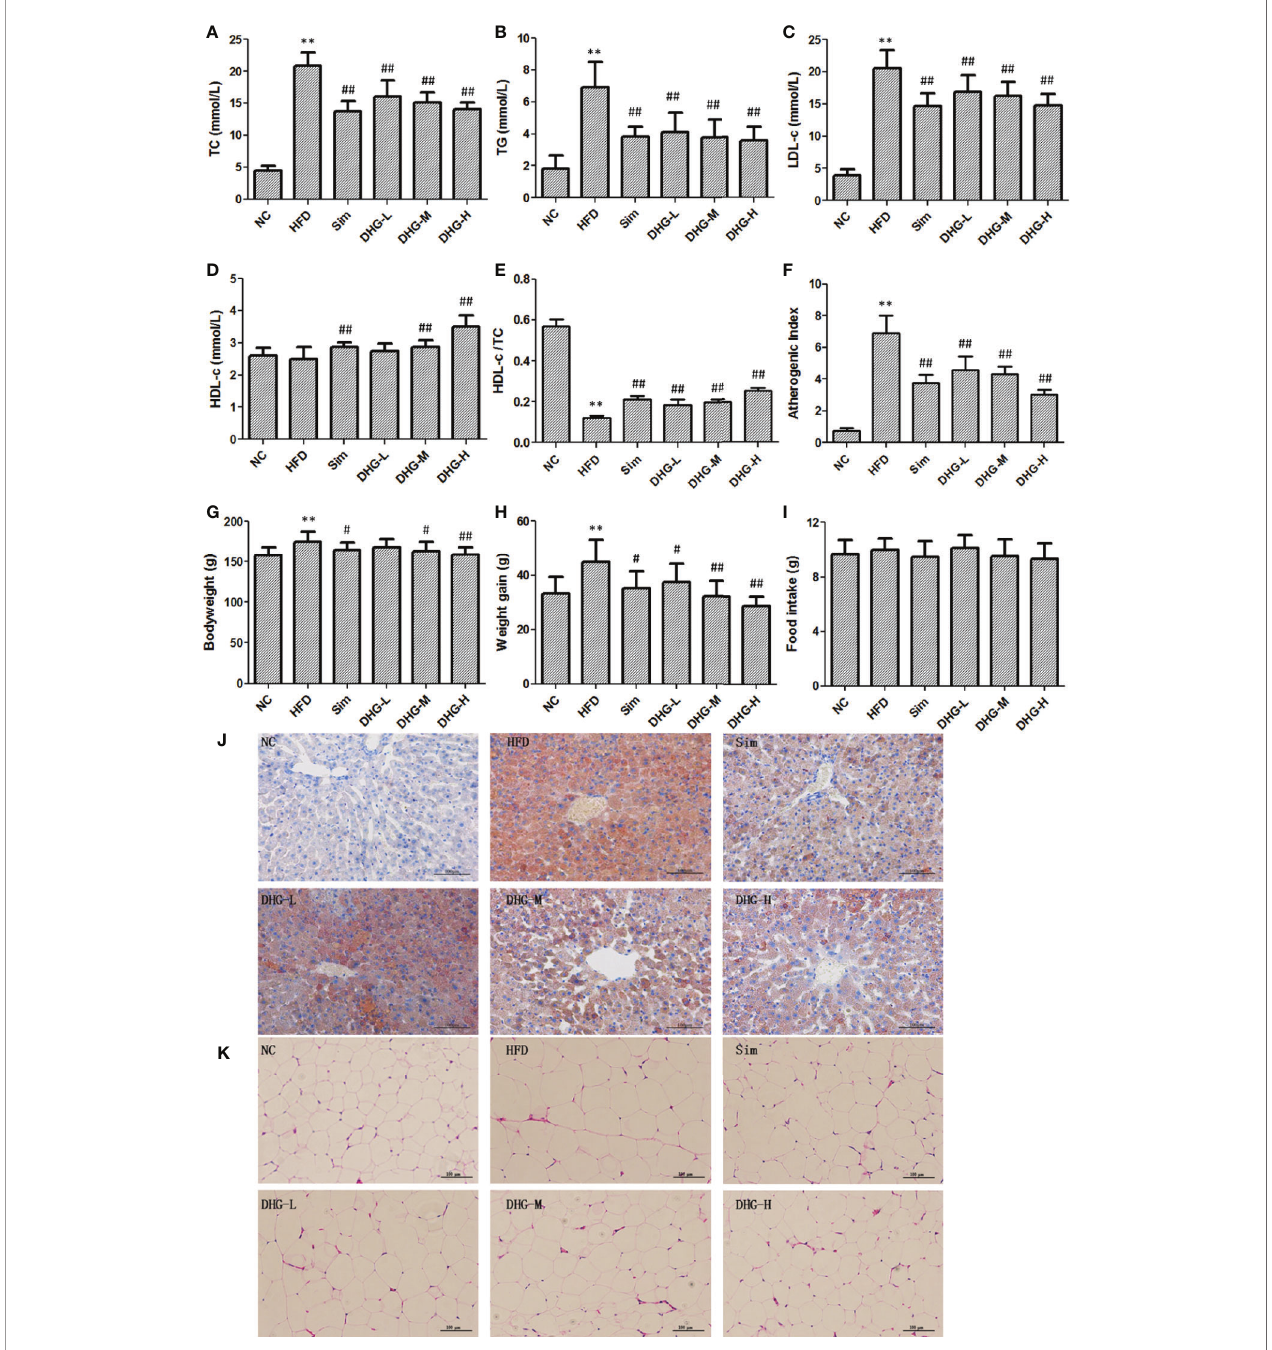
FIGURE 3 | Protective effect of DHG on hyperlipidemic hamsters induced by HFD. Values were mean ± SD, n =10. (A) Serum TC levels. (B) Serum TG levels. (C) Serum LDL-c levels. (D) Serum HDL-c levels. (E) HDL-c/TC ratio. (F) Atherosclerosis index. (G) Body weight in the 10th week. (H) Body weight gain of each group. (I) The food intake of each group. (J) Histological analysis of liver. Liver sections were stained with Oil Red O, Scale bar = 100 m m. (K) Histological analysis of epididymal adipose tissue. Epididymal adipose tissue sections were stained with hematoxylin and eosin, Scale bar = 100 m m. NC, normal control group; HFD, high- fat diet group; Sim, simvastatin (2.40 mg/kg/day); DHG-L, DHG at low dosage (0.37 g/kg/day); DHG-M, DHG at medium dosage (1.10 g/kg/day); DHG-H, DHG at high dosage (3.30 g/kg/day). TC, total cholesterol; TG triglyceride; LDL-c, low-density lipoprotein cholesterol; HDL-c, high-density lipoprotein cholesterol. ** p < 0.01 vs NC; # p < 0.05 vs HFD; ## p < 0.01 vs